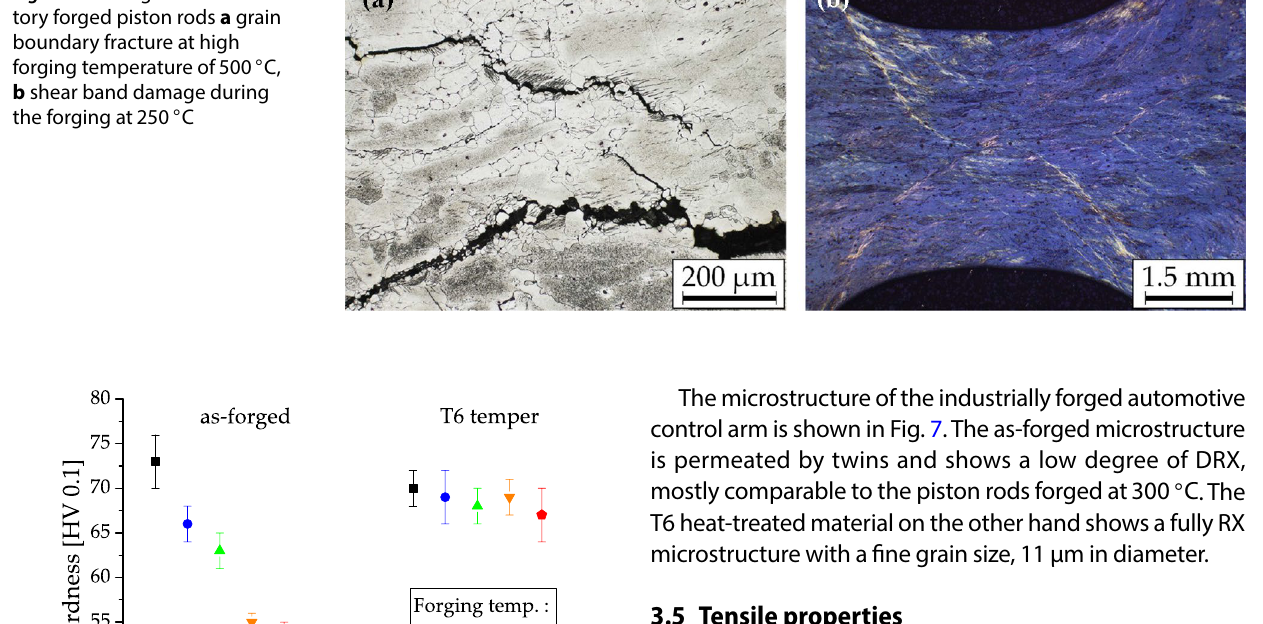
Fig. 4 OM images of labora- tory forged piston rods a grain boundary fracture at high forging temperature of 500 ◦ C , b shear band damage during the forging at 250 ◦ C